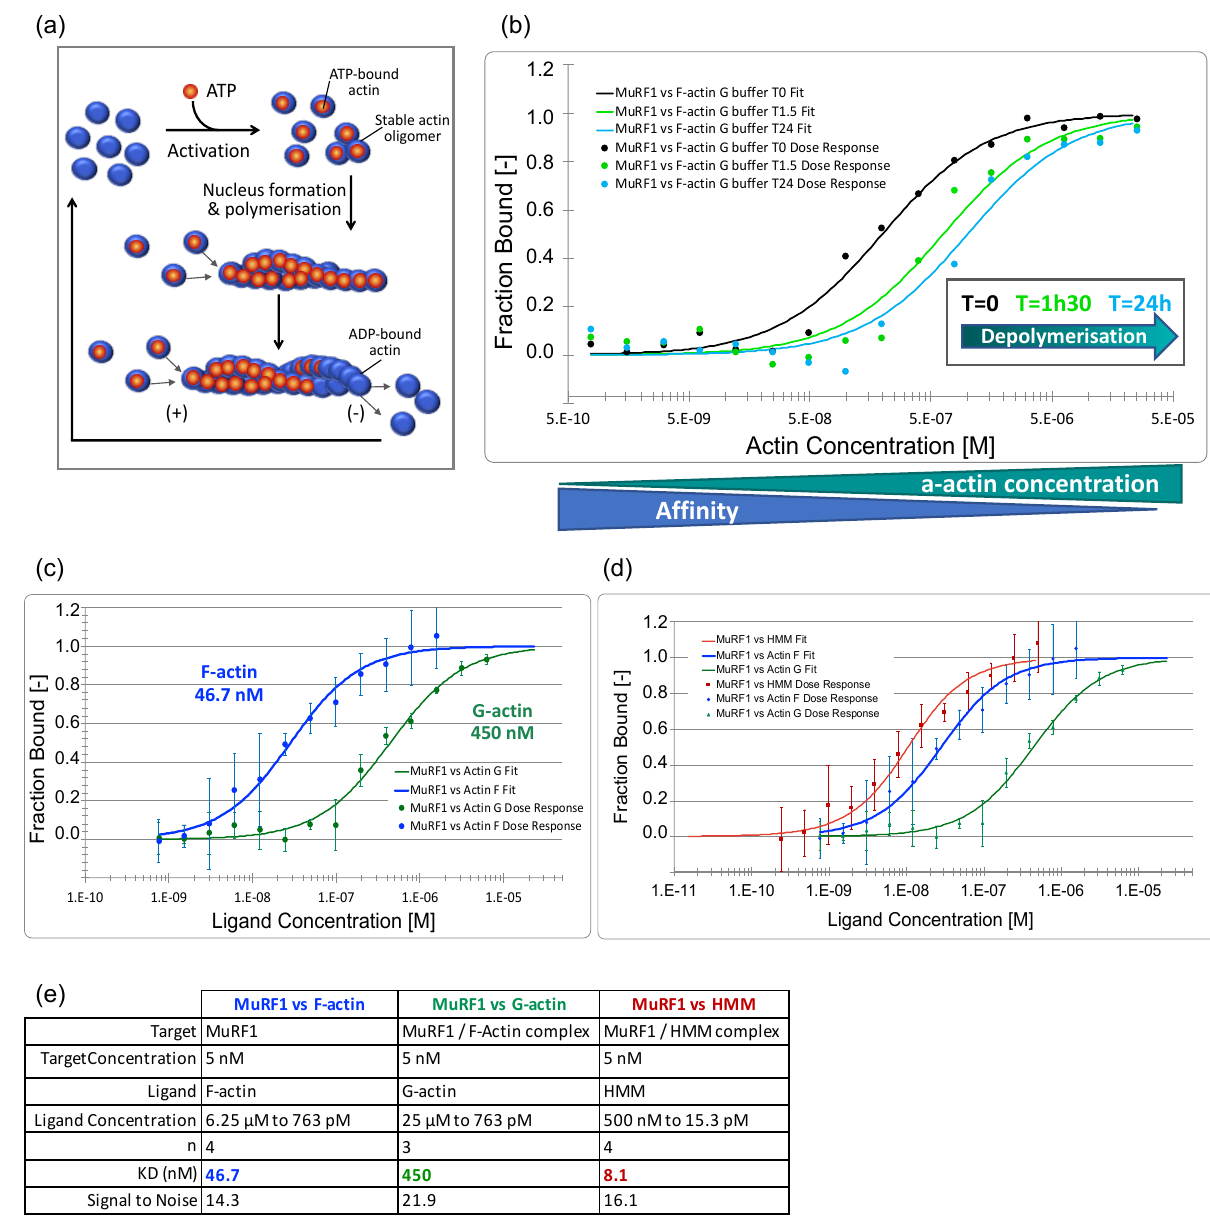
Figure 4. MuRF1 has a high affinity for filamentous actin and heavy meromyosin. ( a ) Scheme of actin poly- and depoly- merization. Actin can be present either as a free monomer (G-actin) or as a linear polymer microfilament called F-actin (filamentous). Monomeric actin polymerizes at >2 mM K+ or Na+, and at >0.05 mM Mg2+. The (+) end of the actin filament tends to capture ATP-actin, thus promoting polarization, while, at the ( − ) end, the actin filament is mostly composed of ADP-actin that promotes depolymerization. A stationary equilibrium is achieved when the G-actin monomers are exchanged at both ends of the microfilament without any change to its total length. ( b ) Interaction of MuRF1 with F-a-actin during F-a-actin depolymerization. Capillaries containing MuRF1 and F-actin in G buffer were read immediately (T = 0 min) or stored for 1 h 30 or 24 h before reading, leading to the depolymerization of actin). ( c ) Dose–response curves for MuRF1 vs. F-actin in F buffer and vs. G-actin in G buffer. ( d ) Dose–response curves for MuRF 1 vs. F-actin in F buffer, vs. G-actin in G buffer and vs. heavy meromyosin (HMM, HMM includes the first 800 amino acids of the MHC, plus the two pairs of light chains). ( e ) Dataset